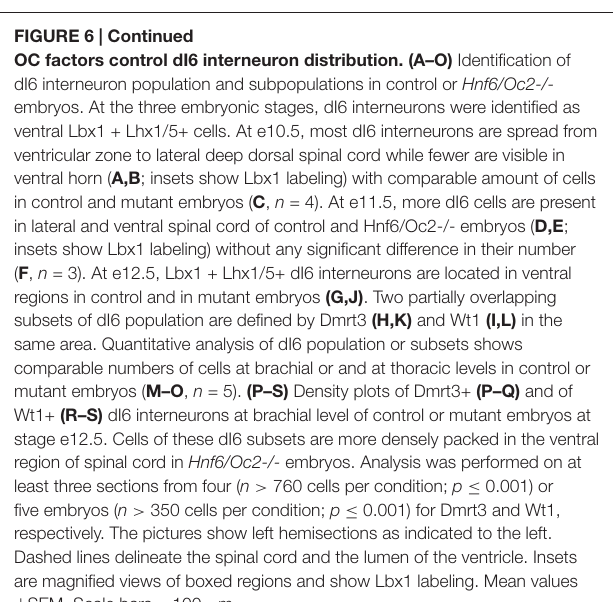
FIGURE 6 | Continued OC factors control dI6 interneuron distribution. (A–O) Identification of dI6 interneuron population and subpopulations in control or Hnf6/Oc2-/- embryos. At the three embryonic stages, dI6 interneurons were identified as ventral Lbx1 + Lhx1/5+ cells. At e10.5, most dI6 interneurons are spread from ventricular zone to lateral deep dorsal spinal cord while fewer are visible in ventral horn ( A,B ; insets show Lbx1 labeling) with comparable amount of cells in control and mutant embryos ( C , n = 4). At e11.5, more dI6 cells are present in lateral and ventral spinal cord of control and Hnf6/Oc2-/- embryos ( D,E ; insets show Lbx1 labeling) without any significant difference in their number ( F , n = 3). At e12.5, Lbx1 + Lhx1/5+ dI6 interneurons are located in ventral regions in control and in mutant embryos (G,J) . Two partially overlapping subsets of dI6 population are defined by Dmrt3 (H,K) and Wt1 (I,L) in the same area. Quantitative analysis of dI6 population or subsets shows comparable numbers of cells at brachial or and at thoracic levels in control or mutant embryos ( M–O , n = 5). (P–S) Density plots of Dmrt3+ (P–Q) and of Wt1+ (R–S) dI6 interneurons at brachial level of control or mutant embryos at stage e12.5. Cells of these dI6 subsets are more densely packed in the ventral region of spinal cord in Hnf6/Oc2-/- embryos. Analysis was performed on at least three sections from four ( n > 760 cells per condition; p ≤ 0.001) or five embryos ( n > 350 cells per condition; p ≤ 0.001) for Dmrt3 and Wt1, respectively. The pictures show left hemisections as indicated to the left. Dashed lines delineate the spinal cord and the lumen of the ventricle. Insets are magnified views of boxed regions and show Lbx1 labeling. Mean values ± SEM. Scale bars = 100 µ